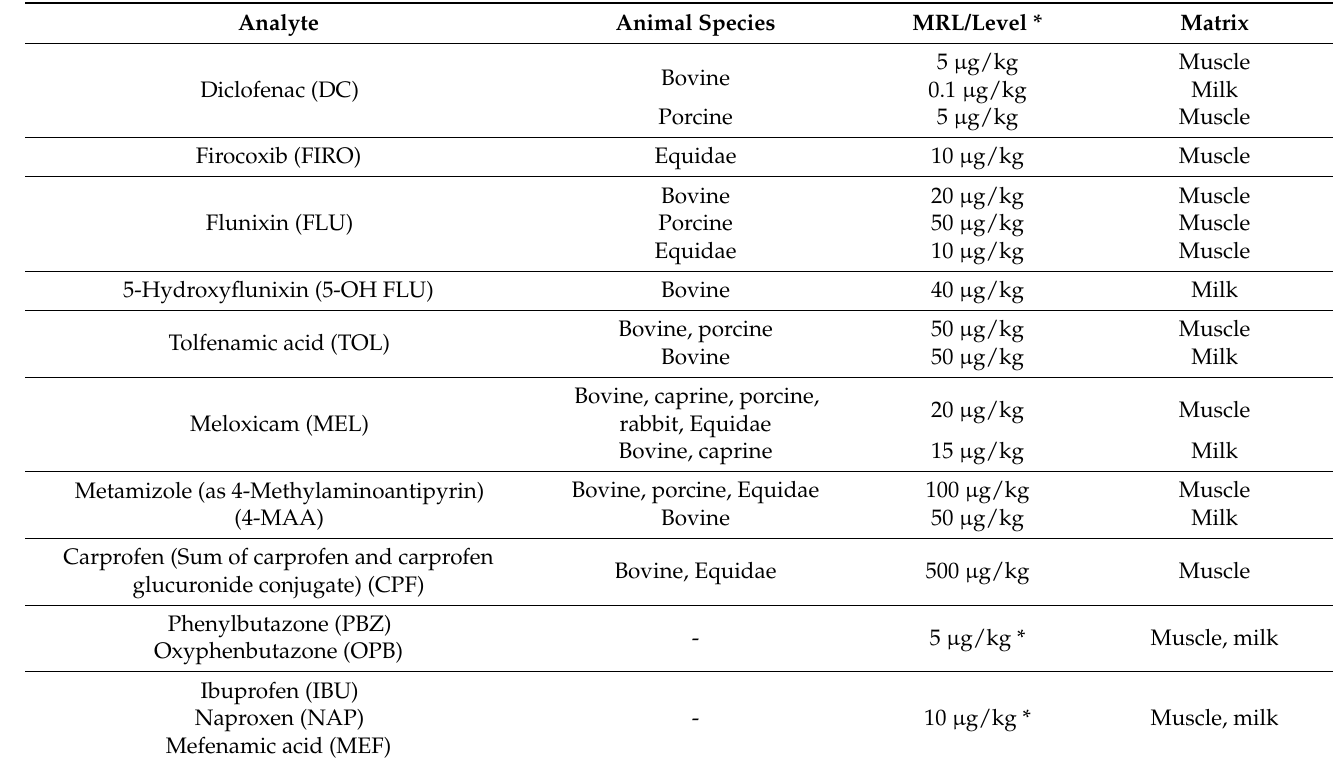
Table 1. MRL levels established by EU in Commission Regulation No 37/2010 (DC, FIRO, FLU, 5-OH FLU, TOL, MEL, 4-MAA, CPF) [6] and levels * recommended by CRL guidance paper (PBZ, OPB, IBU, NAP, MEF)